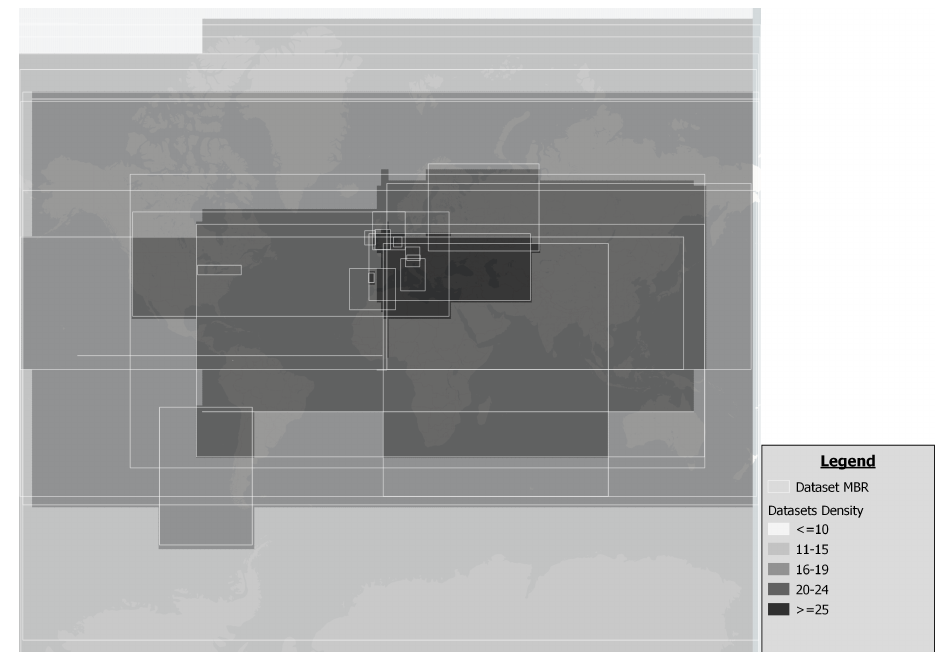
Figure 7. Spatial datasets minimum bounding rectangles and